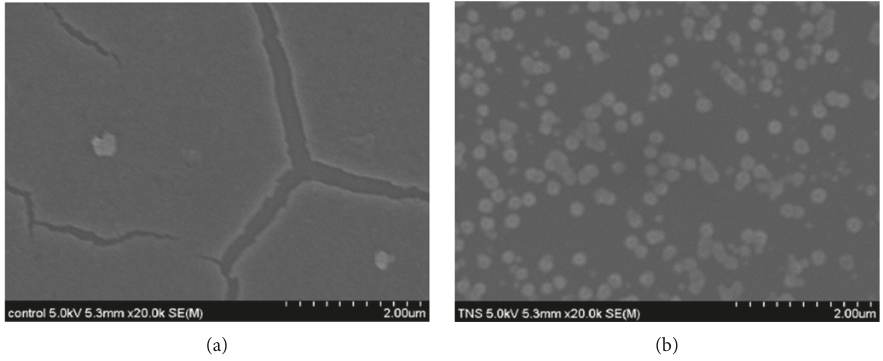
Figure 11: SEM images of exposure to SBF solution on (a) Ti and (b) TNS QCM